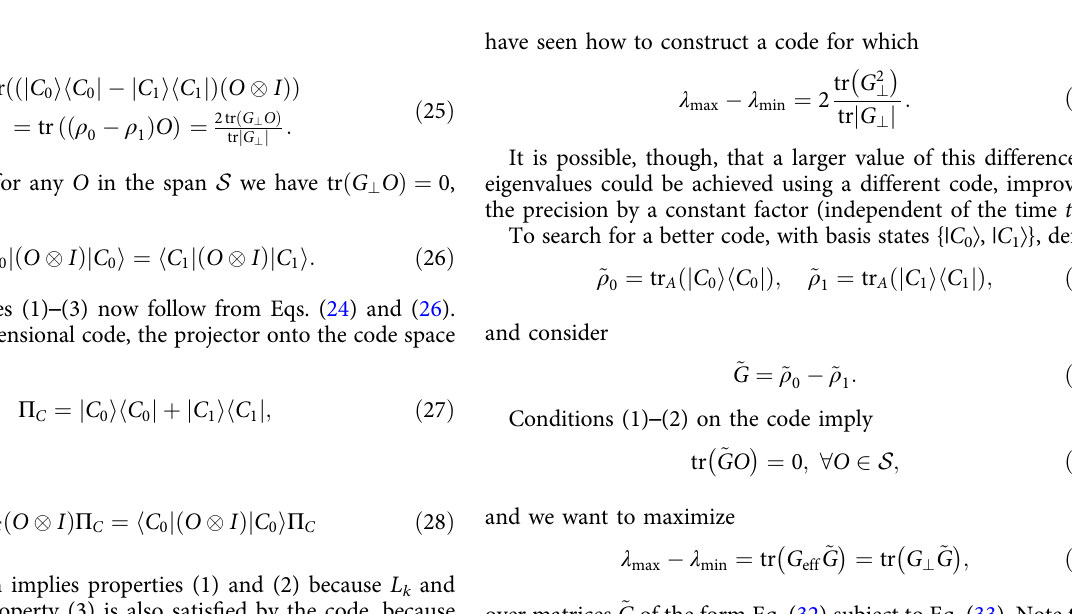
Fig. 2 Schematic illustration of HNLS and code optimization. a G ? is the projection of G onto S in the Hilbert space of Hermitian matrices equipped with the ffiffiffiffiffiffiffiffiffiffiffiffiffiffiffiffiffi p Hilbert-Schmidt norm . G ? ≠ 0 if and only if G = 2S , which is the HNLS condition. b ~ G } is the projection of G onto S in the linear space of Hermitian tr ð O (cid:6) O Þ matrices equipped with the operator norm O k k ¼ max ψ j i ψ h j O ψ j i . In general, the optimal QEC code can be contructed from ~ G } and ~ G } is not necessarily equal to G